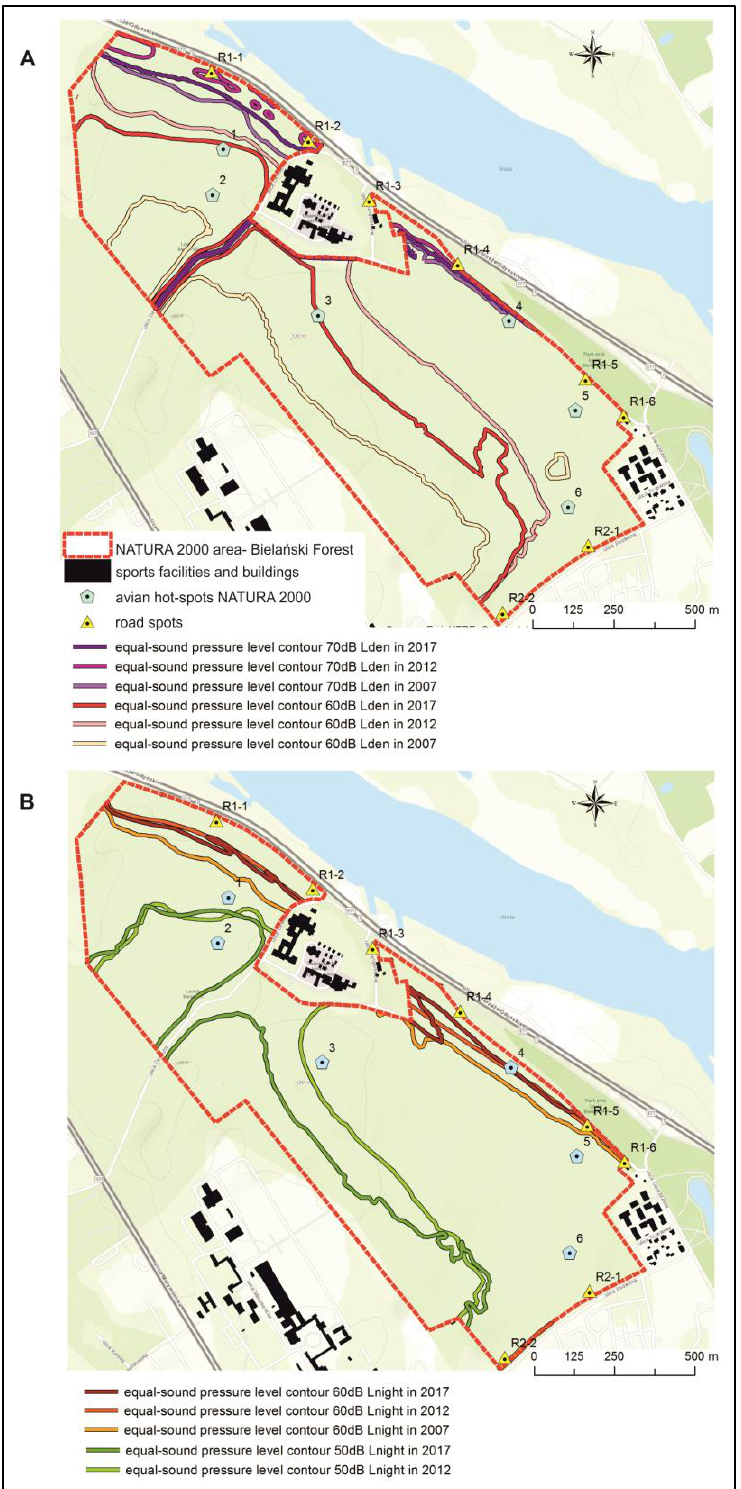
Figure 3. Changes in the location of the selected equal-sound pressure level contours in the years 2007, 2012 and 2017; ( A )—for Lden, and ( B )—for Lnight.